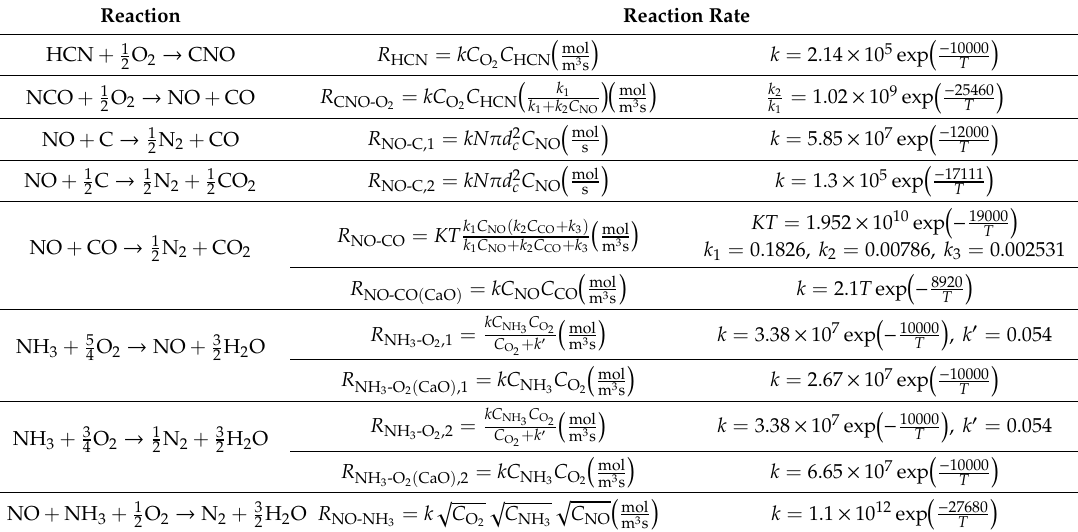
Table 1. NO x generation and